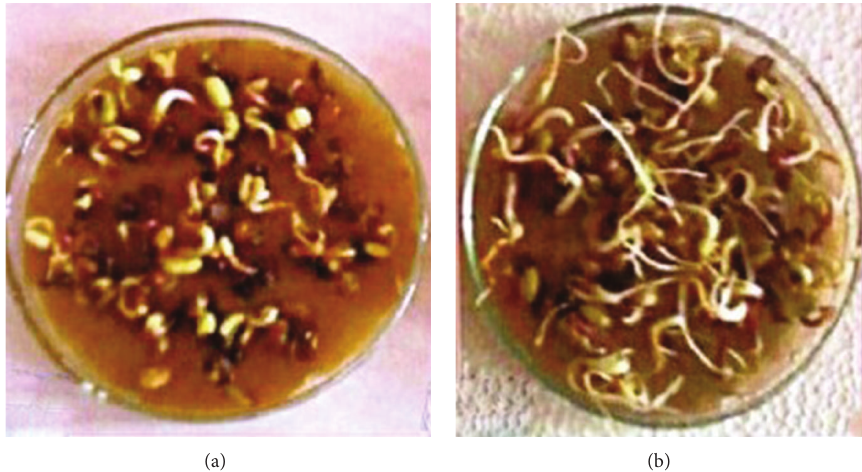
Figure 6: Seedling growth under (a) raw effluent and (b) treated effluent.